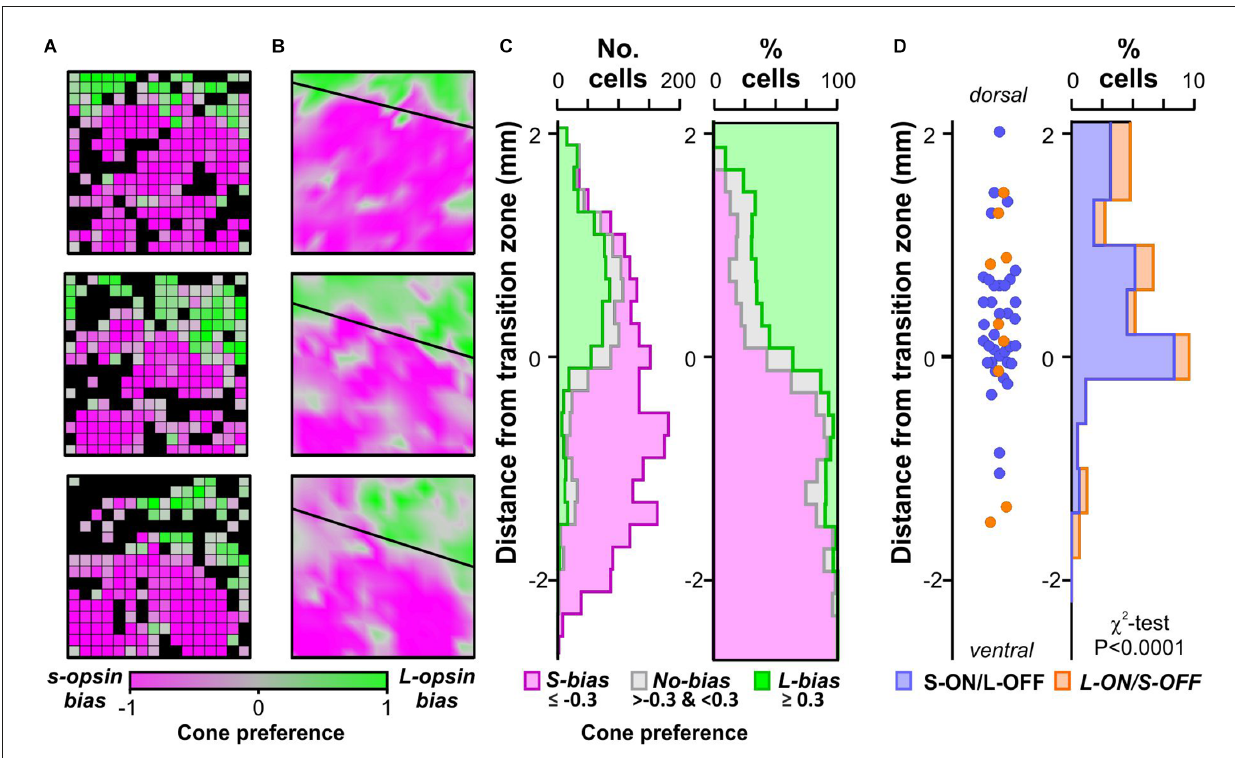
FIGURE2 Distributionofcolouropponencyacrosstheretina. (A) Populationlevelconepreferencefromthree256-channelMEArecordings(spanning3 × 3mm of retina). Black colour indicates electrodes where we did not detect significant modulations in multiunit firing to either L- or S-opsin isolating stimuli. (B) Interpolated map of retina cone-preference from experiments in (A) showing opsin transition zone modelled by linear fitting. (C) Spatial distribution of isolated units with strong S-opsin bias, no bias, or strong L-opsin bias relative to modelled opsin transition zone ( n = 1,429 cells from 25 retinas). Left panel shows numbers of isolated cells, right panel shows same data as a proportion of total for that location. (D) Spatial distribution of isolated colour opponent units relative to modelled opsin transition zone ( n = 36 S-ON/L-OFF and n = 9 L-ON/S-OFF cells). Left panel shows estimated locations of individual cells, right panel shows binned proportions of colour opponent cells relative to all cells isolated within that region (data analysed by χ 2